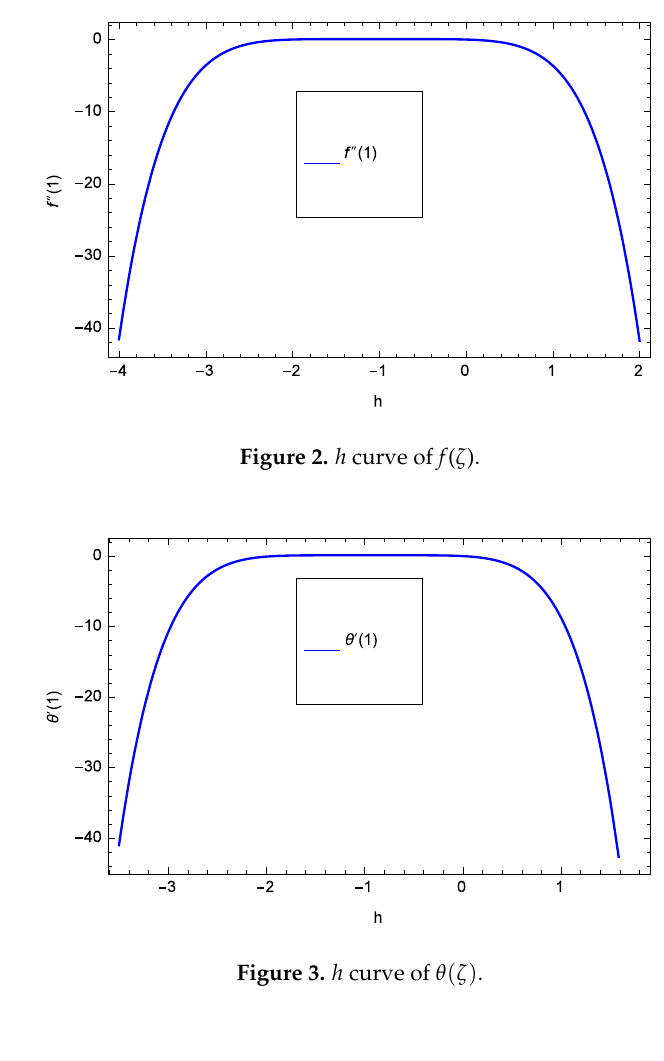
Figure 3. h curve of θ ( ζ )